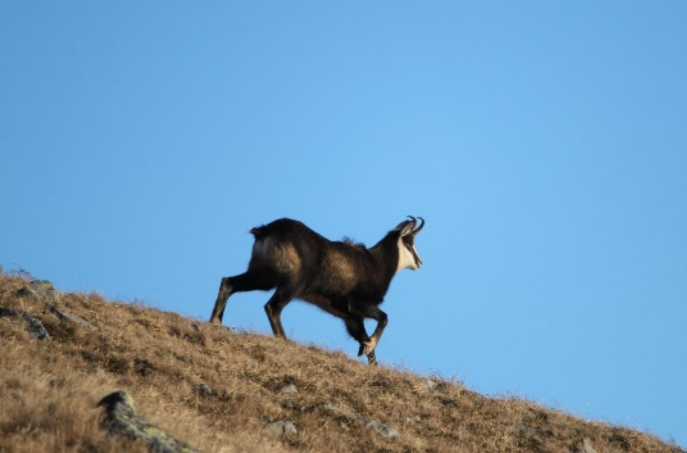
Figure 5. Alpine chamois in its typical habitat in the Krúpova ho ľ a Mts. (photo: P. Urban).